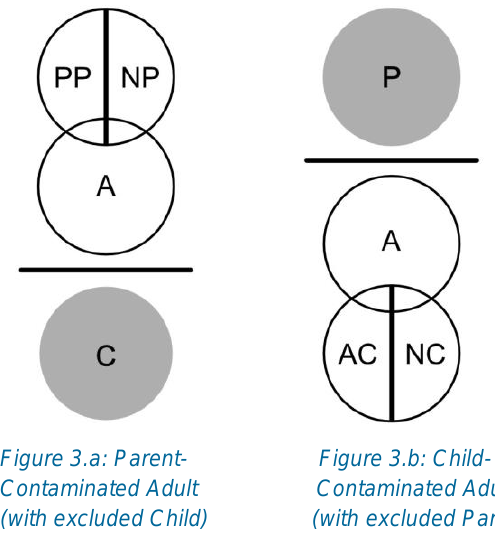
Figure 3.a: Parent- Figure 3.b: